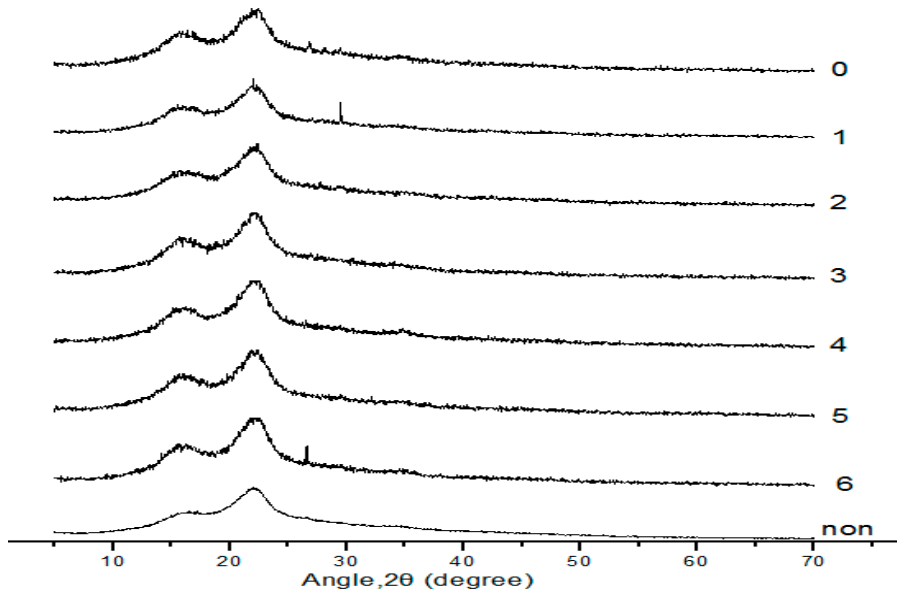
Figure 6. XRD of untreated straws and straws treated with alkaline black liquor circulation with different times.